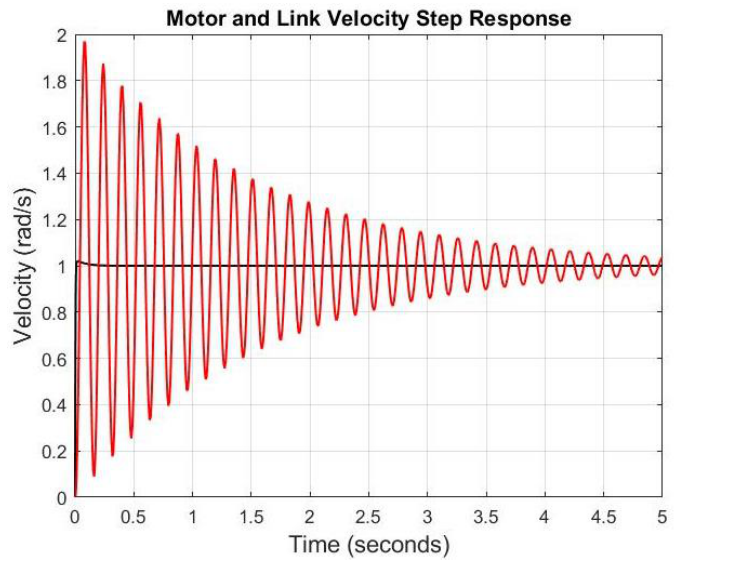
Figure 11. Motor and Link velocity time responses—Black line: Motor Response; Red line: Link Response.